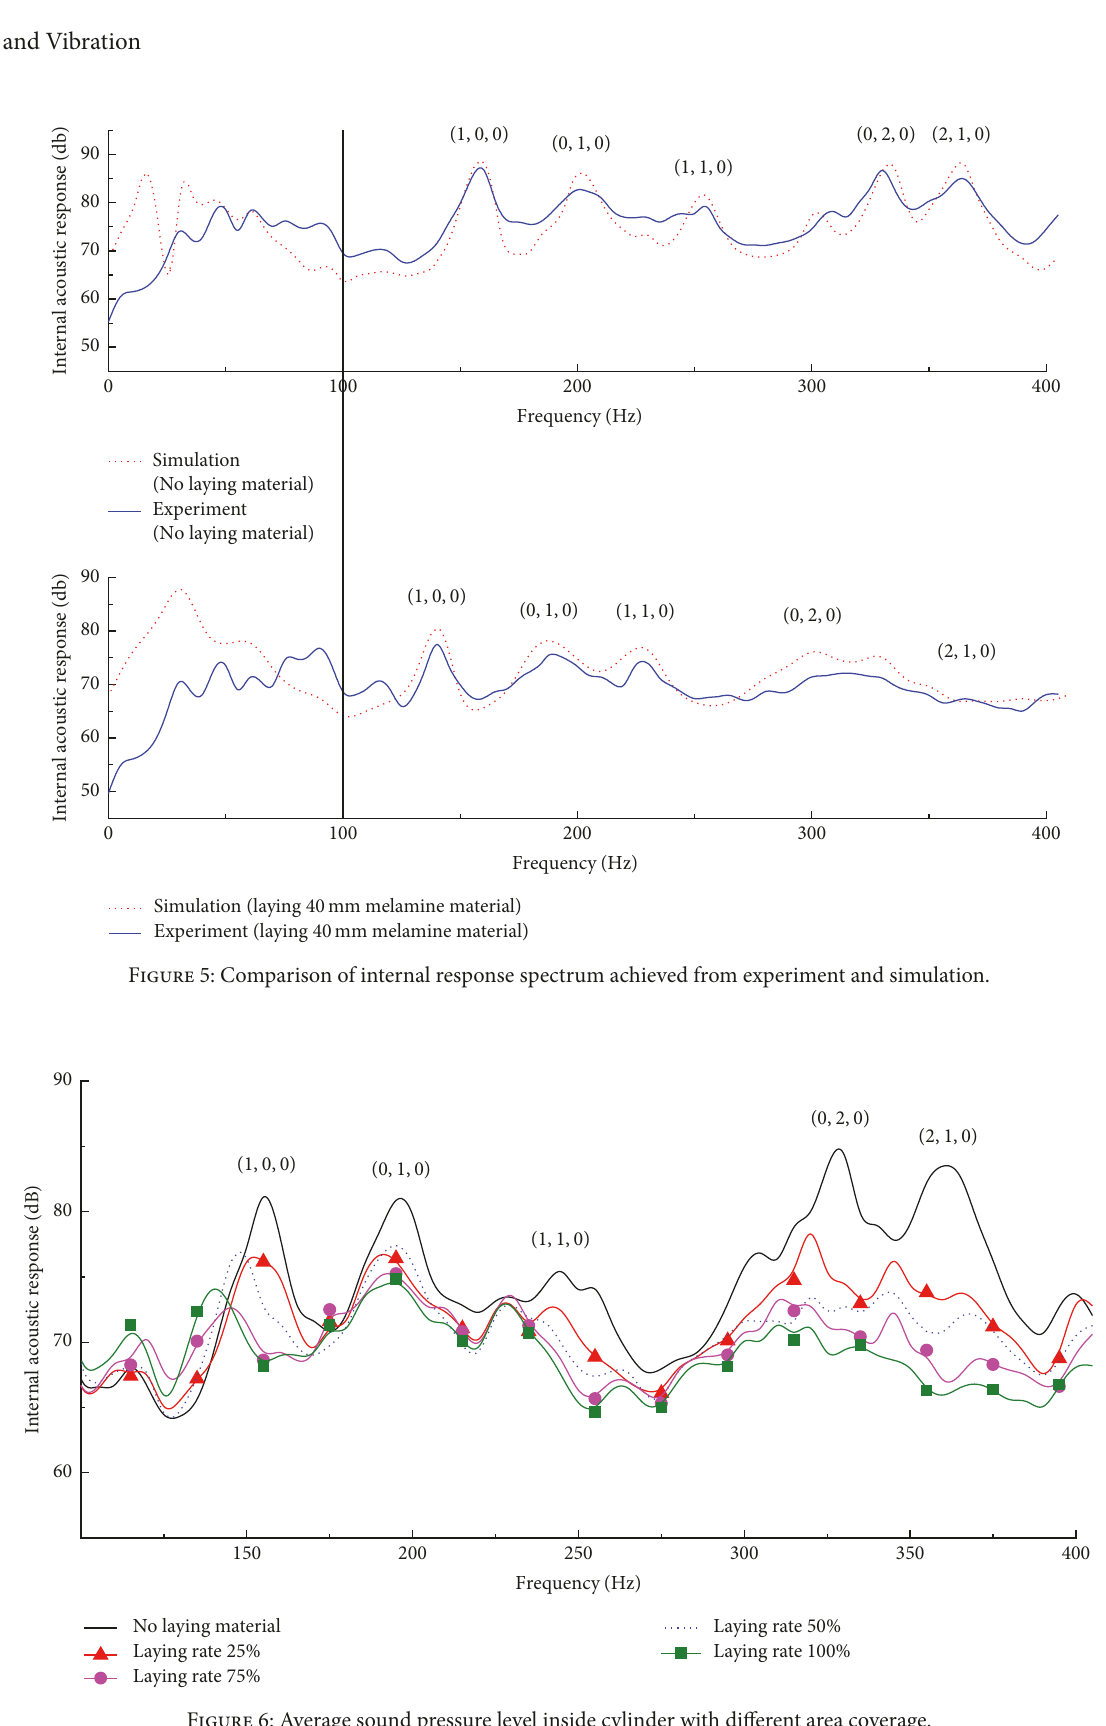
Figure 6: Average sound pressure level inside cylinder with different area